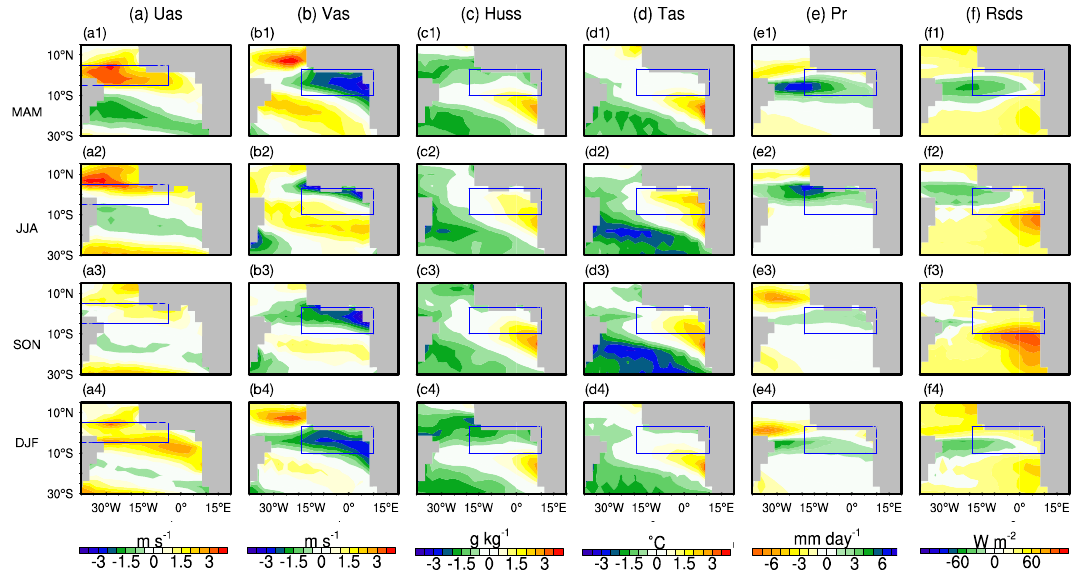
Figure 4. Bias of surface zonal wind (uas; ( a ); unit: m s −1 ), surface meridional wind (vas; ( b ); unit: m s −1 ), surface specific humidity (huss; ( c ); unit: g kg −1 ), surface air temperature (tas; ( d ); unit: °C), precipitation (pr; ( e ); unit: mm day −1 ), and downward shortwave radiation (rsds; ( f ); unit: W m −2 ) in MAM (top), JJA (second row), SON (third row), and DJF (bottom) during 1979–2005 in H_CCM. The blue box denotes the ACT region. Note that the color bar in ( e ) is reversed.